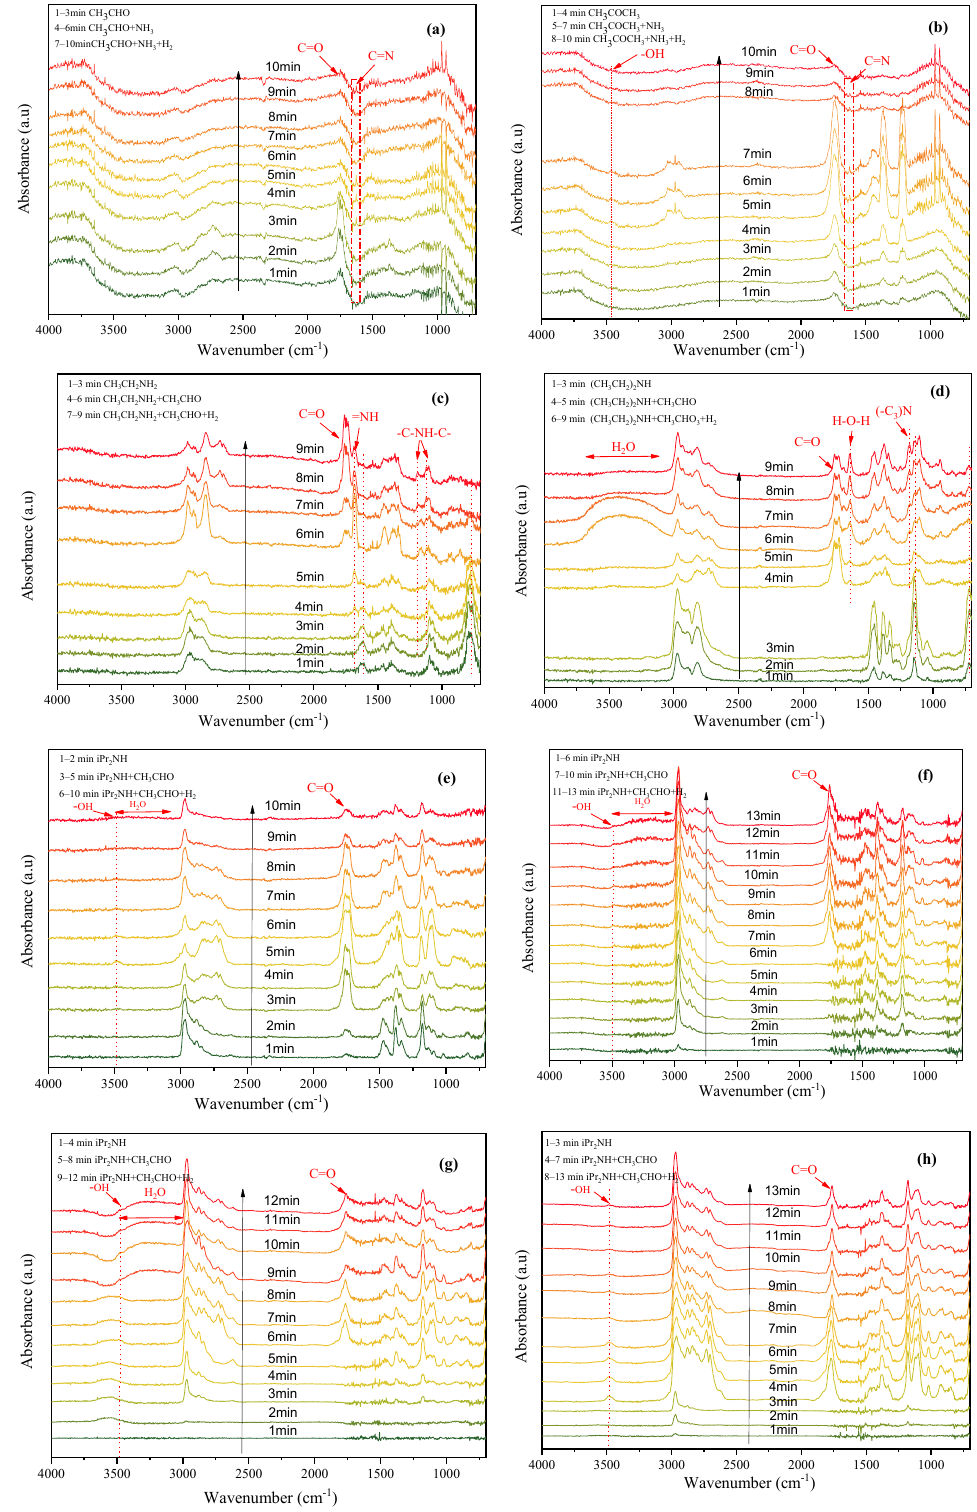
Figure 5. ATR-FTIR spectra recorded during hydrogenation of different substrates: ( a ) CH 3 CHO and NH 3 , ( b ) CH 3 COCH 3 and NH 3 , ( c ) CH 3 CH 2 NH 2 and CH 3 CHO, ( d ) (CH 3 CH 2 ) 2 NH and CH 3 CHO, ( e ) iPr 2 NH and CH 3 CHO, ( f ) iPr 2 NH and CH 3 CHO. ( a – e ) commercial 1.0 wt% Pd/ACs, ( f ) 1.1 wt% Pd(OH) 2 /g-C 3 N 4 , ( g ) 1.2 wt% Pd/g-C 3 N 4 , ( h ) 1.1 wt% PdO/g-C 3 N 4. The “1.0 wt%” represents the Pd